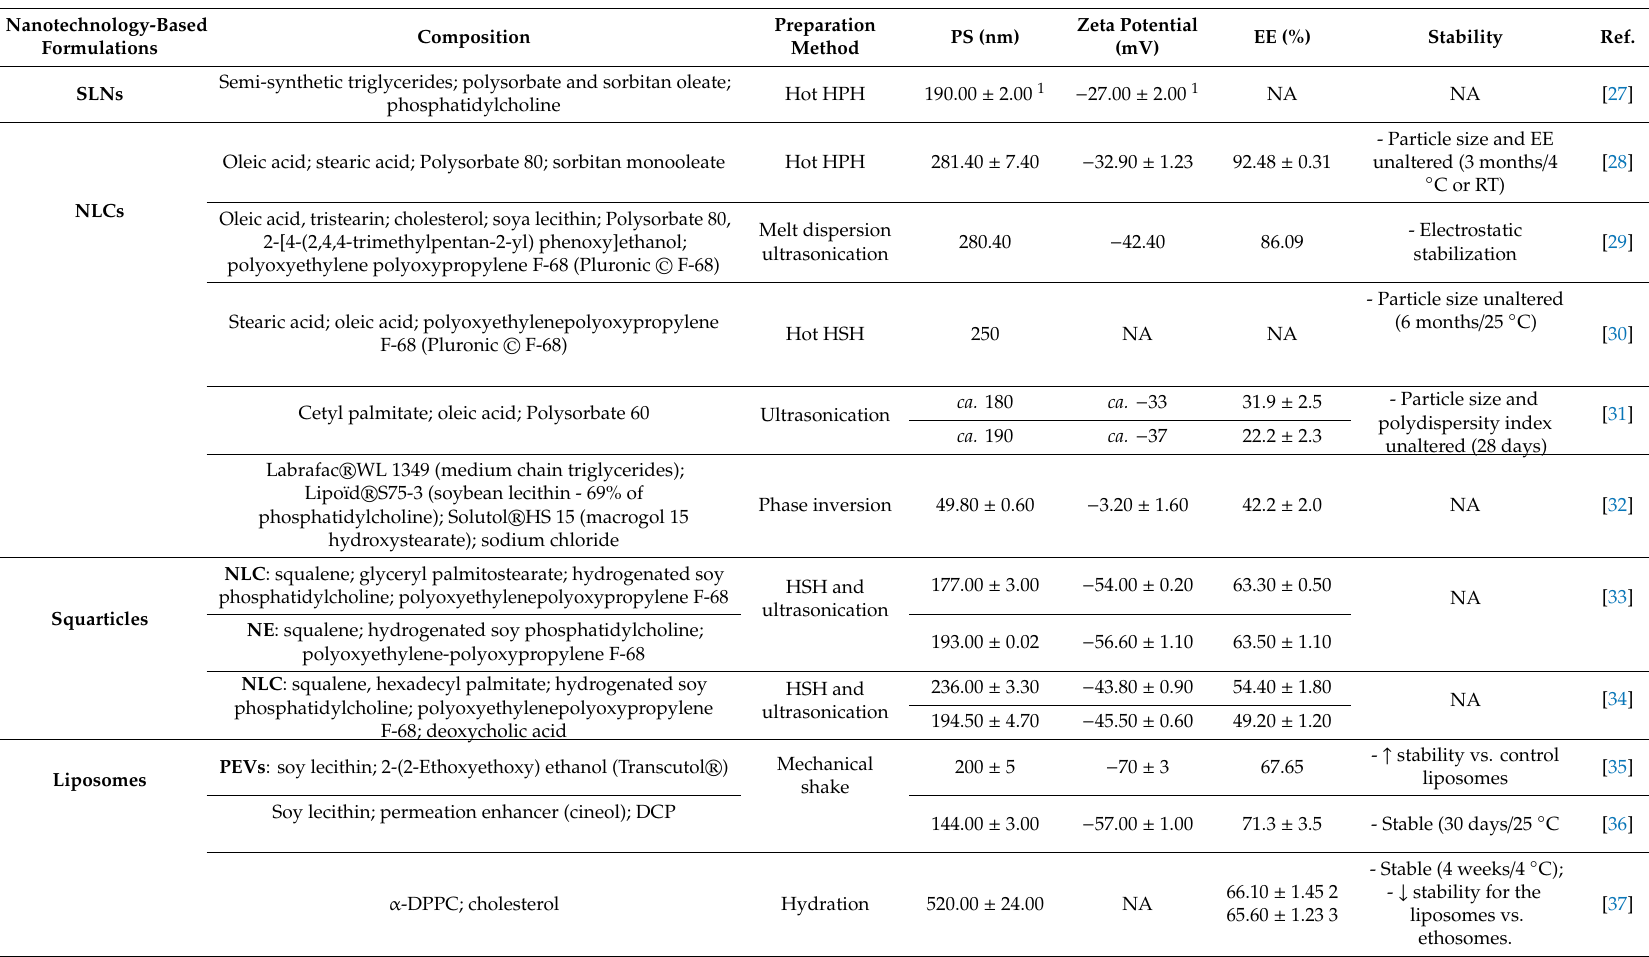
Table 1. Nanotechnology-based formulations applied to topical administration of